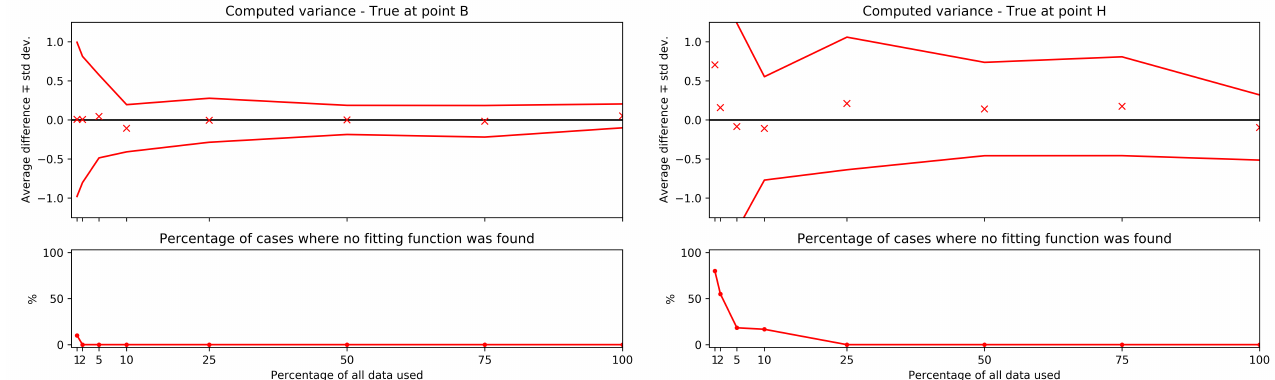
Figure 4. Sensitivity of PROM to the density of data. The top of each plot represents the error between the computed variance and the true value of 1 averaged for many realisations. The lines represent the standard deviation of these errors around the average. The bottom part of each plot shows how many of the realisations PROM method failed to obtain a